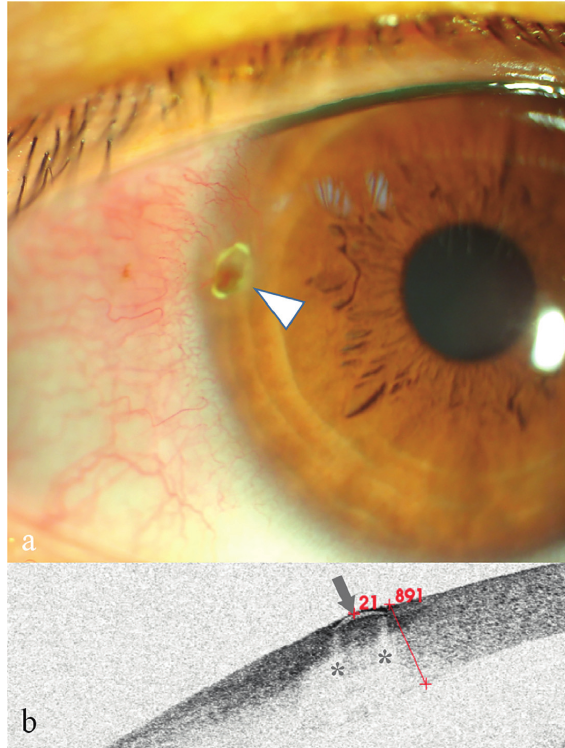
Figure 4: Anterior segment and AS-OCT image for Case 4. (a) Anterior segment photograph showing multiple cream-like corneal opacities (arrowheads) surrounding a wrinkled transparent cornea. (b) AS-OCT image showed multiple spines (high signals) with blurred boundary (arrows) on the superficial epithelium followed by a central zone shadowing effect (stars). The corneal thickness was 546 μ m, within the normal range.